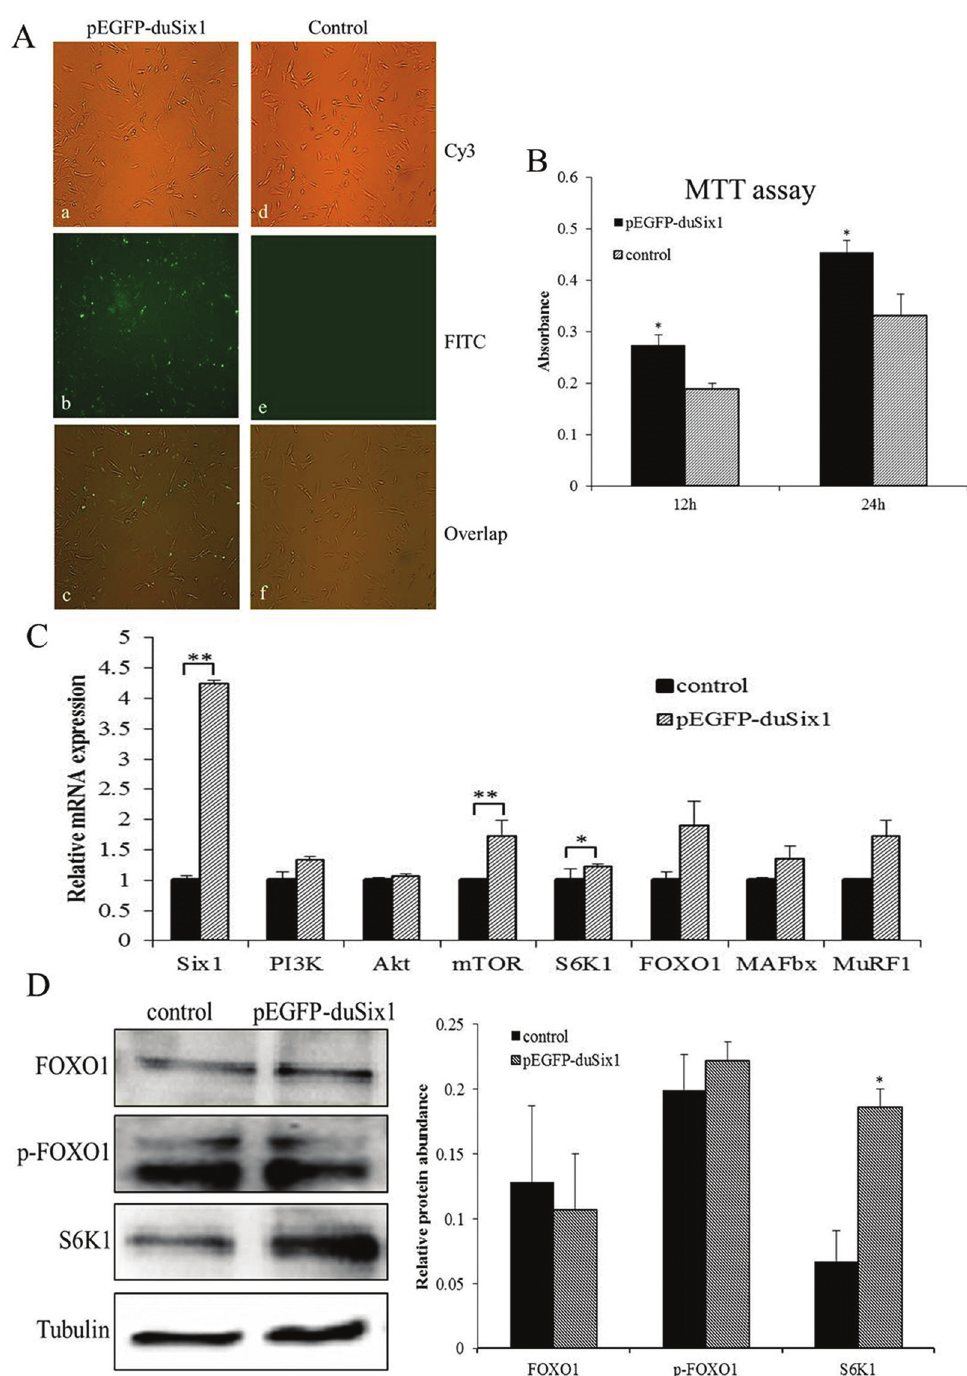
Figure 1 - Effects of overexpression of Six1 on protein synthesis and degradation in duck myoblasts. A: The expression of GFP in duck myoblasts after transfection of Six1 (100). Notes: (a), (b) and (c) are pEGFP-duSix1-transfected myoblasts and (d), (e) and (f) are non-transfected myoblasts (control). (a) and (d) showed the shape of the myoblasts in the Cy3 channel; (b) and (e) showed the green fluorescent protein in the FITC channel; (c) and (f) show the overlap of (a) with (b) and (d) with (e), respectively. B: Effects of Six1-transfection on the cellular proliferation of duck myoblasts at 12 h and 24 h after transfection. Cellular proliferation was measured by colorimetric MTT assay. Absorbance was measured at 570 nm, and data are presented as means (cid:6) SEM,n=5wells.C:Relativeexpressionlevelsof Six1 andthekeygenesrelatedtoproteinsynthesisanddegradationinduckmyoblastsaftertransfection. Duck (cid:2) -actinand GAPDH wereusedastheinternalcontrols.**(P<0.01)and*(P<0.05),valuesaremeans (cid:6) SEM,n=3foreachgroup.D:Westernblot analysis showing the effect of Six1-transfected on protein expression of FOXO1, p-FOXO1, S6K1 in duck myoblasts. Bar graphs showing quantification of the expression level of each protein compared with the expression of tubulin. Data are expressed as means (cid:6) SEM. Western blots are representative of three independent experiments. Western immunoblots probed with antibodies against FOXO1, phospho-FOXO1, S6K1 and tubulin were used as internal